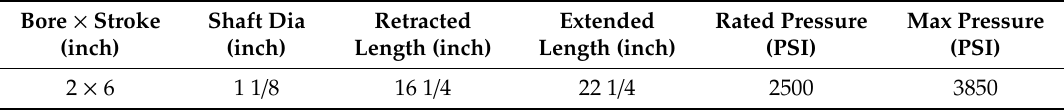
Table 4. The hydraulic cylinder